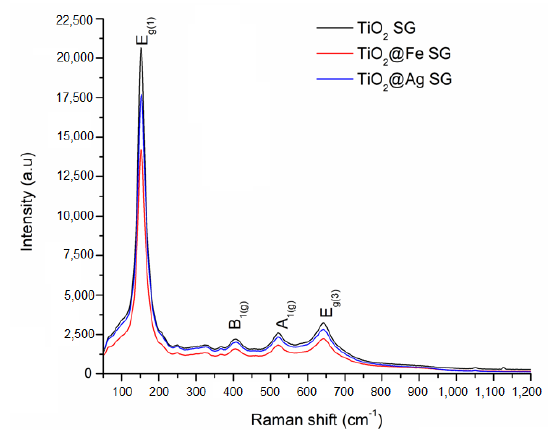
Figure 5. Raman analysis corresponding to the samples obtained by the sol-gel (SG) method.